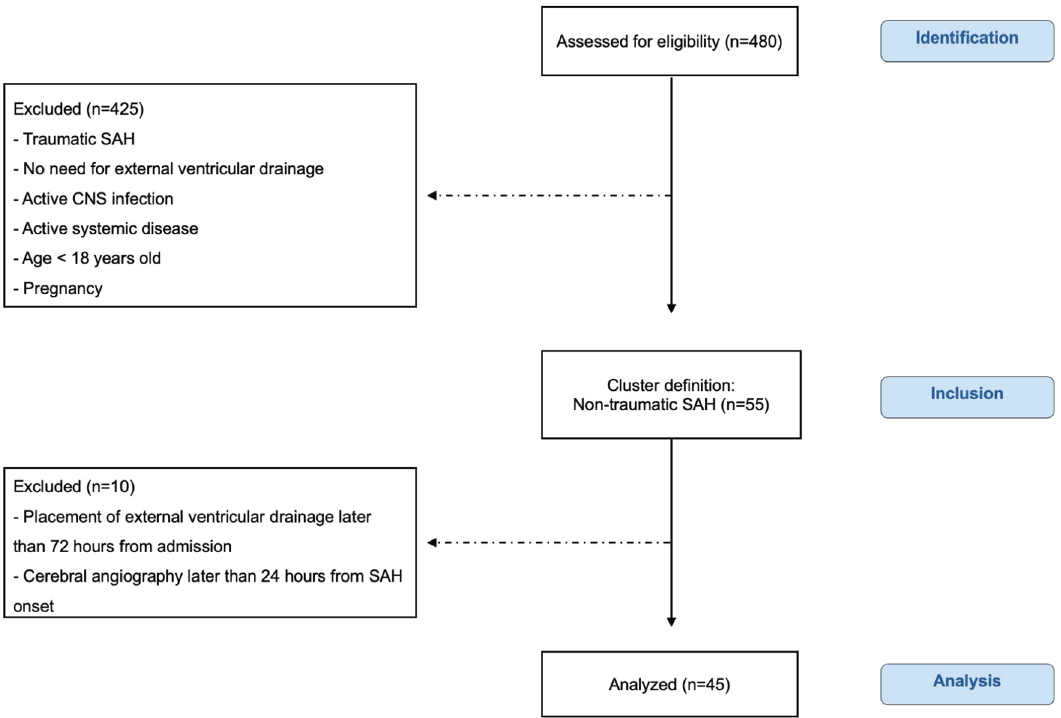
Figure 1. Flowchart illustrating the inclusion/exclusion criteria of individuals in the study. Chart data for 480 patients who were admitted for spontaneous SAH to the Intensive Care Unit in the Neurosurgical Department, IRCCS Ospedale San Raffaele, Milan, Italy. According to inclusion and exclusion criteria, 45 patients affected by spontaneous non-traumatic SAH were included in the study. Abbreviations: CNS = Central nervous system; SAH = Subarachnoid hemorrhage;